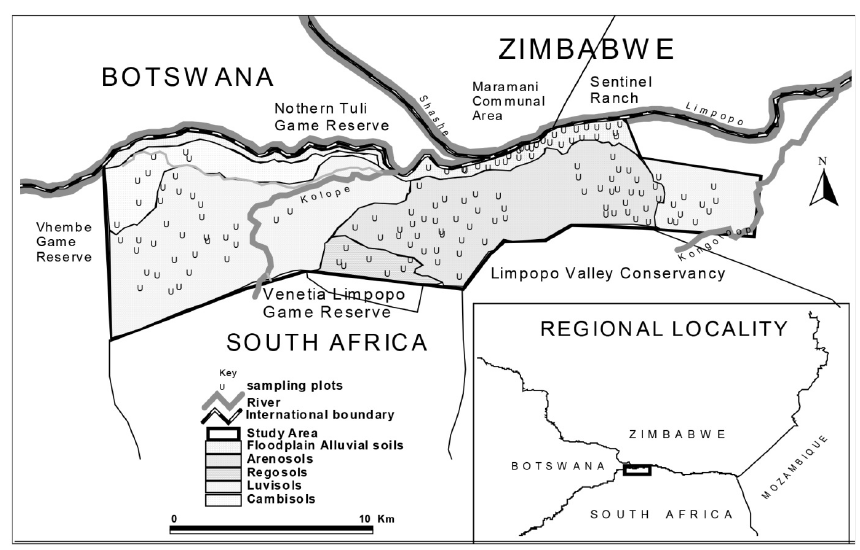
Fig. 1: Location of the study area Mapungubwe Cultural Landscape (MCL), main soil substrates and sampling plots, Limpopo Province, South